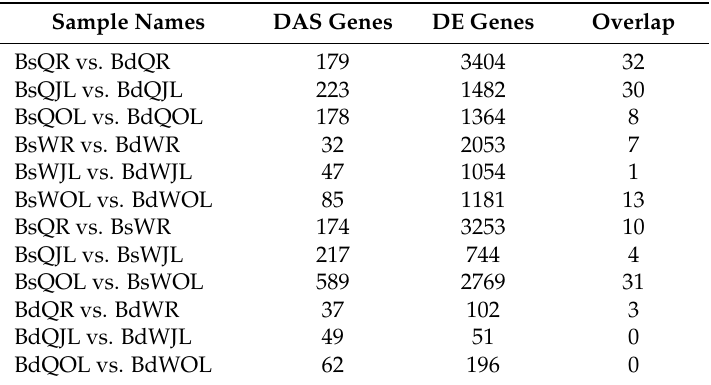
Table 5. The number of differential alternative splicing genes and differential expressed genes in the root, juvenile leaf and old leaf of B. napus cultivars Qingyou10 and Westar10 under boron deficient